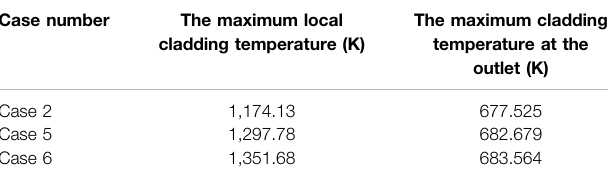
TABLE 6| Thelocal peak cladding temperature and the maximum temperature at the